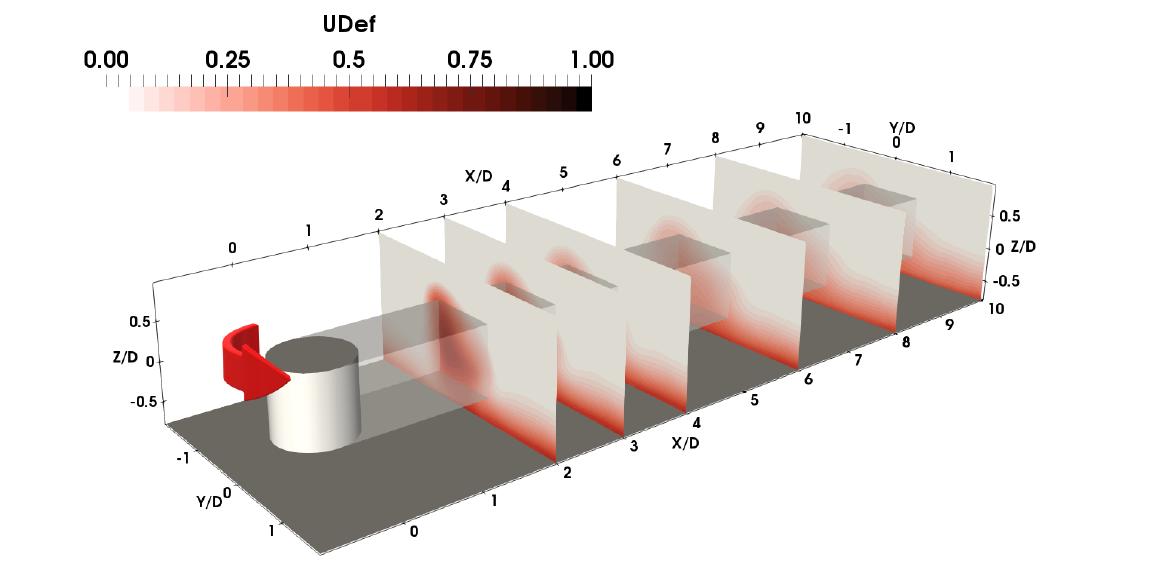
Figure 5. Average axial velocity deficit at different locations in the wake of the turbine. Axis origin is the center of the turbine. Dimensions are scaled by the turbine diameter. The results are from ALM-LBM simulation with Mesh No. 2. U Def = 1 − < U x > / U H /2